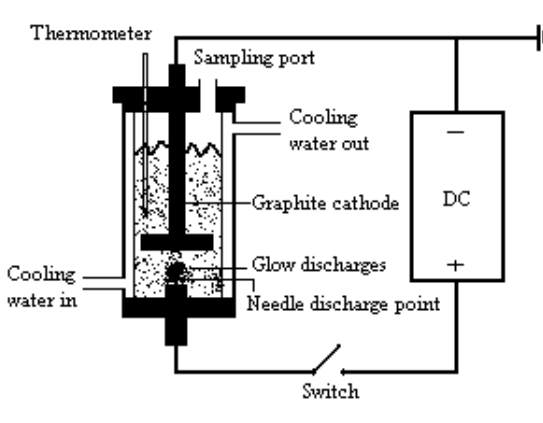
Fig. 1 The experimental